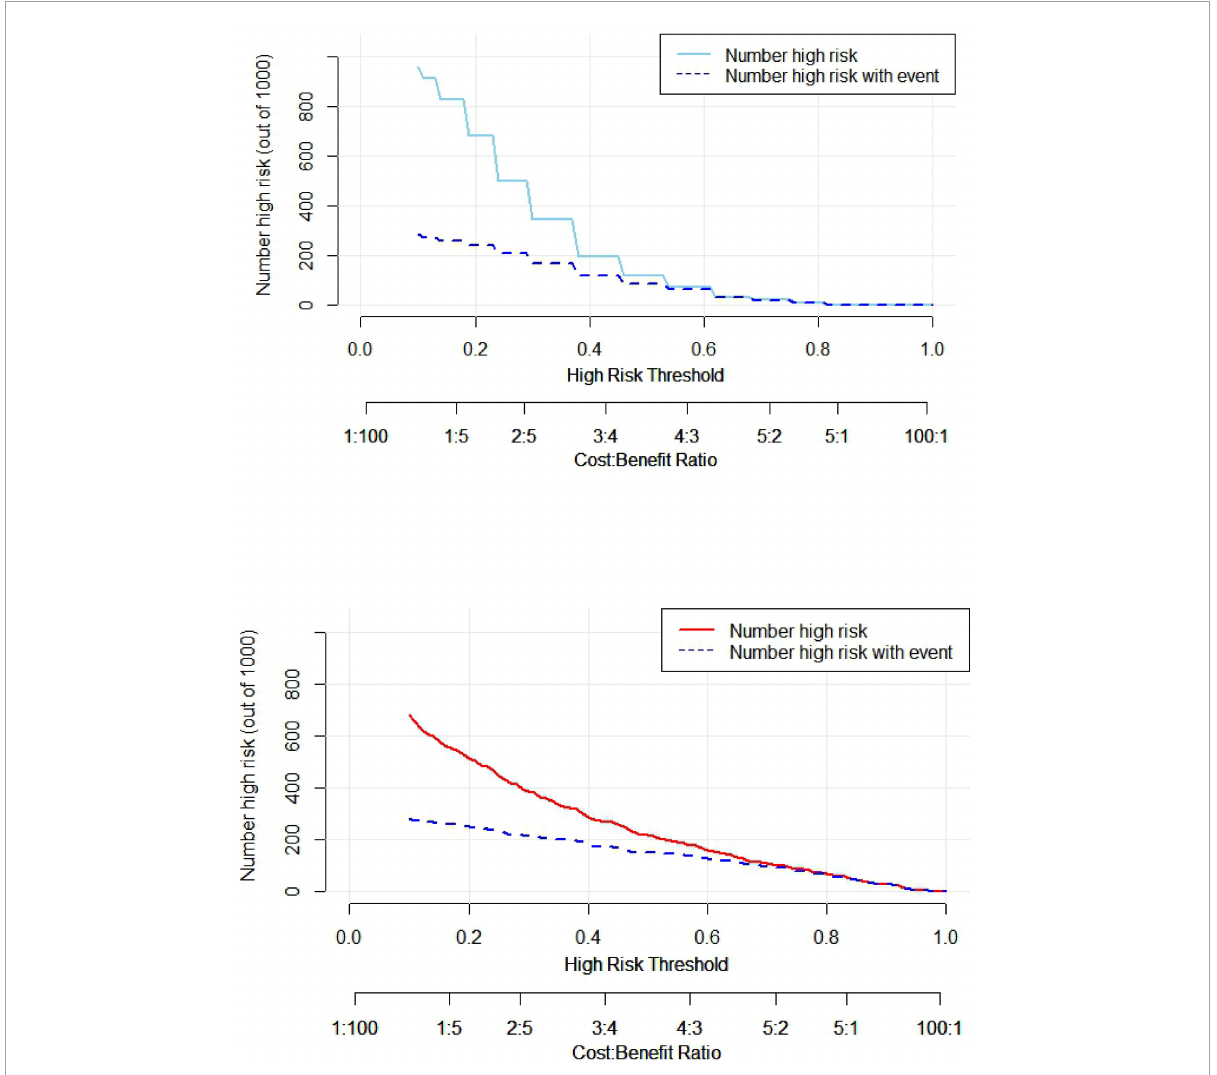
FIGURE6 Analysis of clinical impact curve between nomogram model and TIMI score single